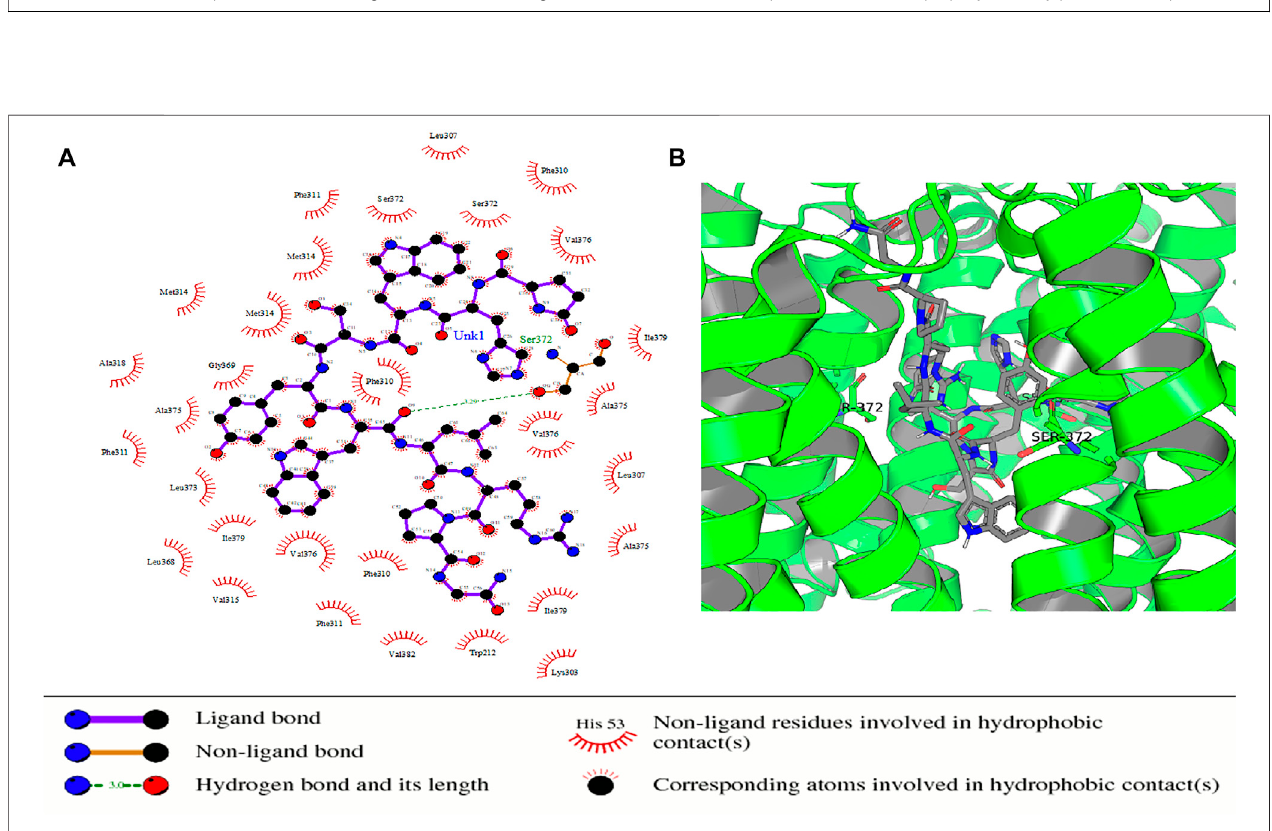
FIGURE 8 | Protein – ligand complex of STEAP2 and Drugbank1543 shows residue Ser-372 from the 6th TM domain according to the MSA of STEAP2s and this forms a hydrogen bond with an atom of the ligand (Drugbank 1543). The rest of the interacting receptor residues are shown as crescents and these form other bonds with the receptors. These interacting residues are many compared to other complexes and contribute a signi fi cant binding energy of the complex.